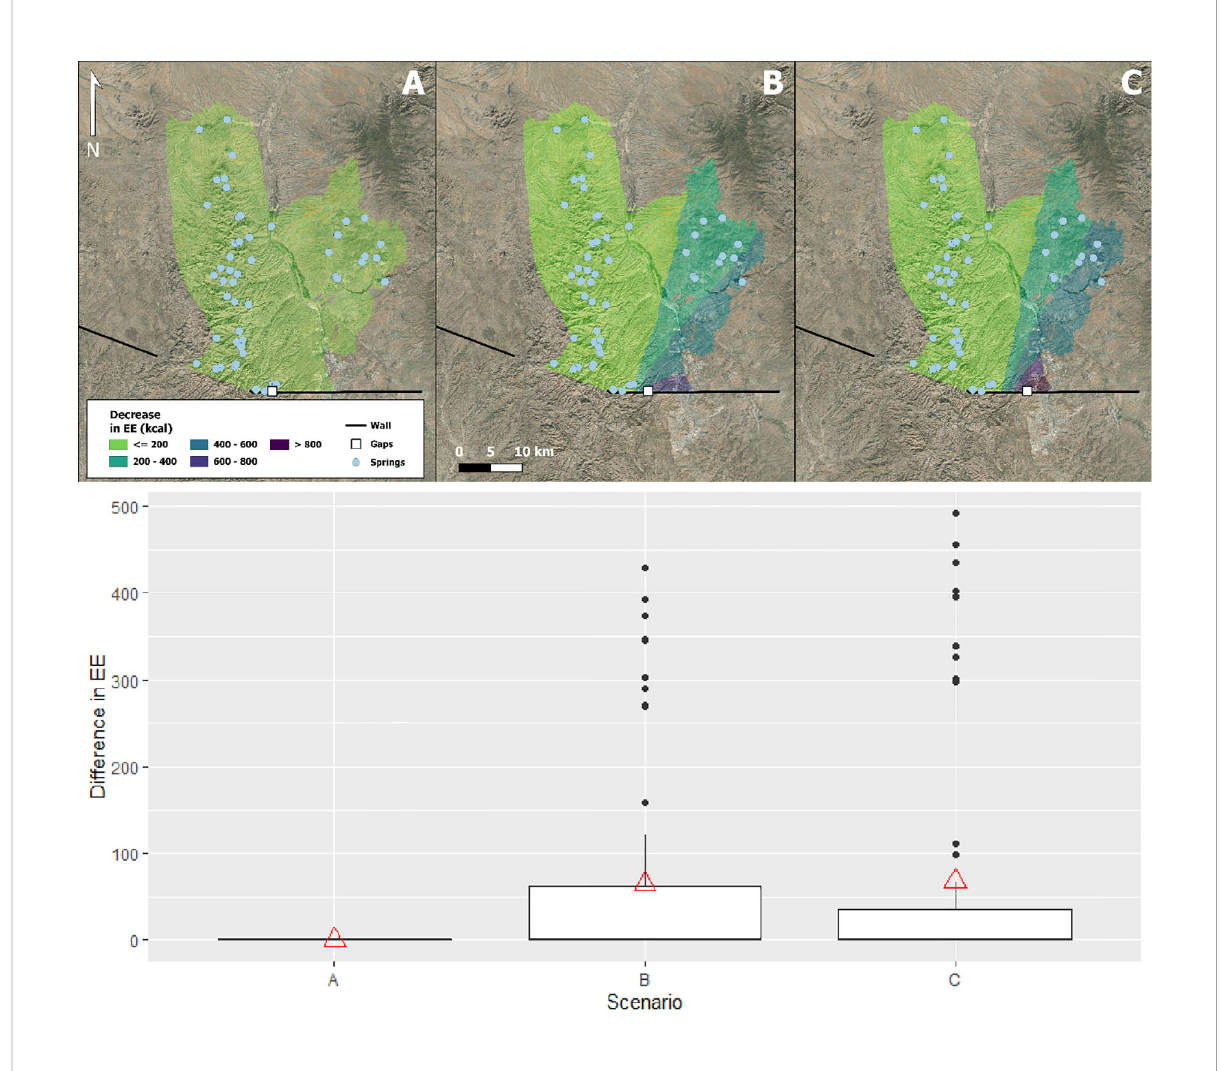
FIGURE 3 Maps showing decrease in energy expenditure (kcal) from 2021 walled scenario for remediation scenarios ( A – C ) and box and whisker plots of difference in energy expenditure, from 2021 walled energy expenditure (y-axis), for each remediation scenario (x-axis), ( A – C ). Greatest change is seen in scenario (B) while scenario (A) shows no difference between 2021 and remediation. Triangles mark mean energy expenditure for each difference in